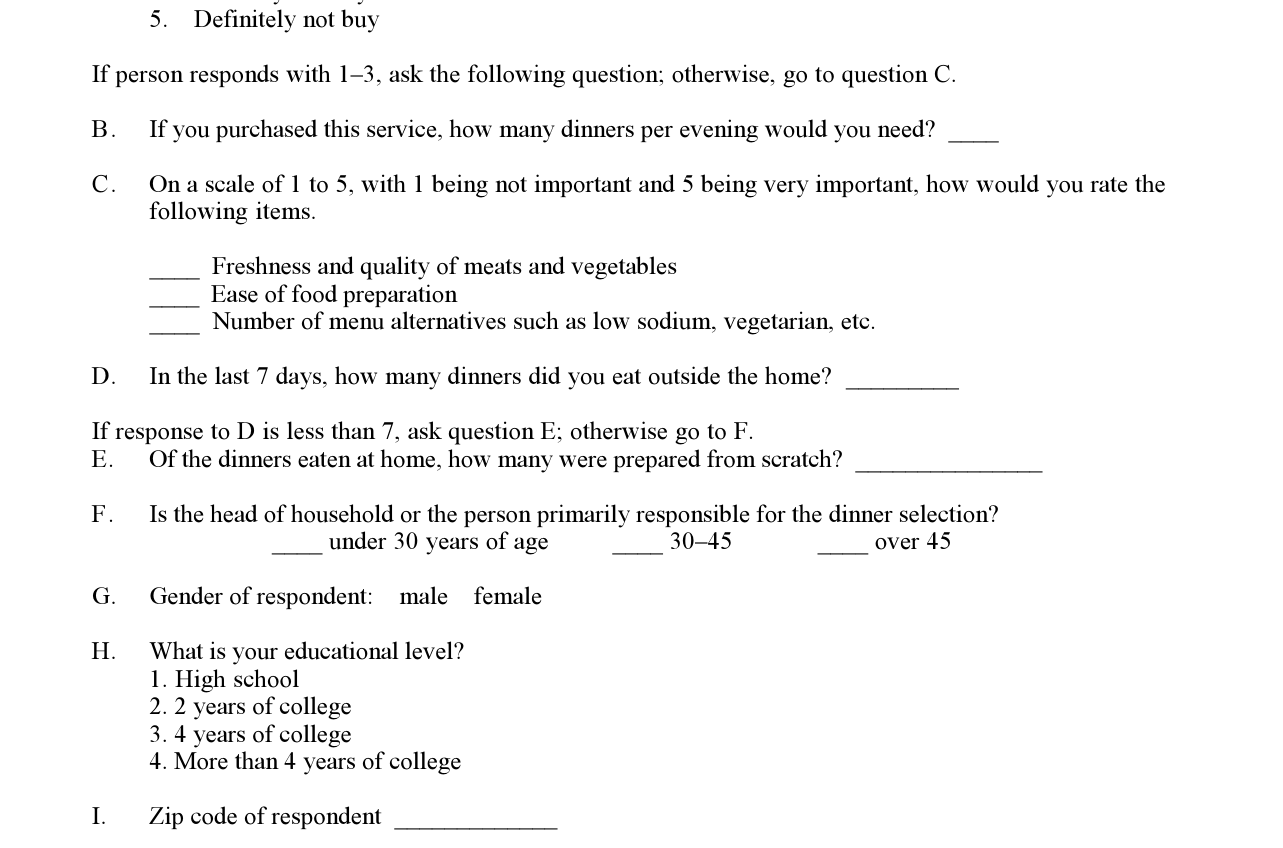
Figure 1. Consumer-Oriented Concept